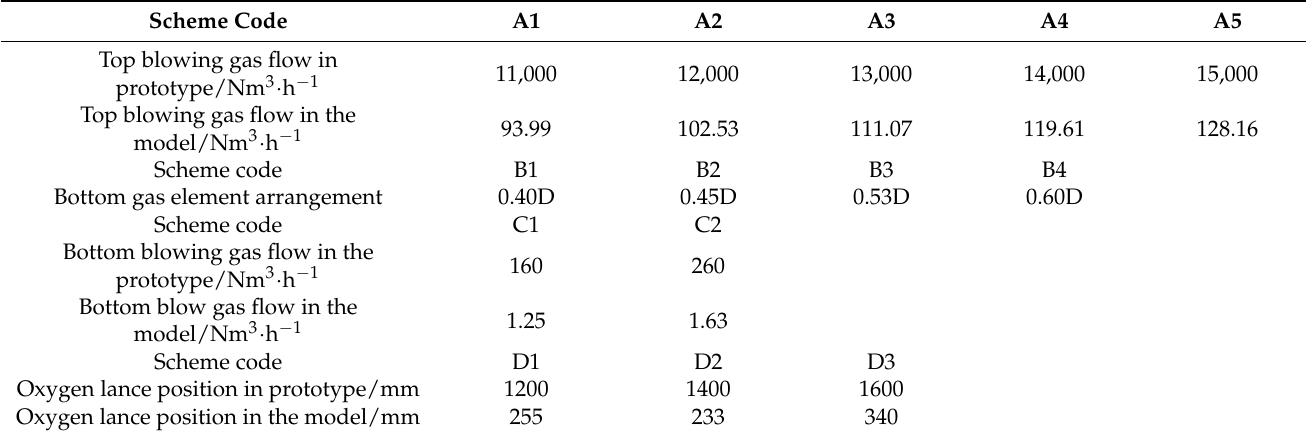
Table 3. Blowing parameters used in the water mold